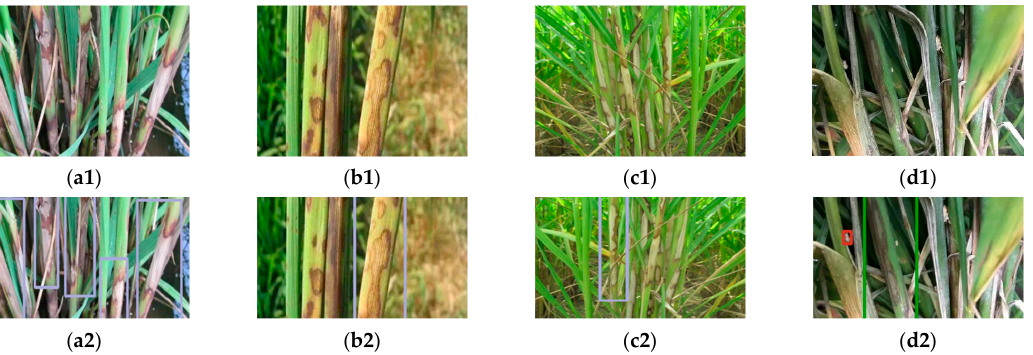
Figure 7. Rice sheath blight. ( a1 ), ( b1 ), ( c1 ), and ( d1 ) are the original images; ( a2 ), ( b2 ), ( c2 ), and ( d2 ) are the recognition results.